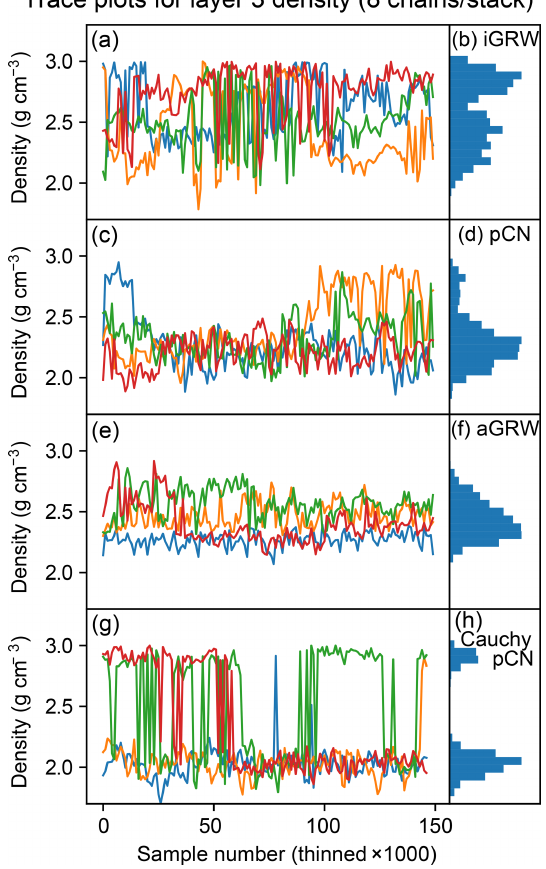
Figure 3. Trace plots (a, c, e, g) and marginal densities (b, d, f, h) for layer 3 rock density as explored by iGRW, pCN, and aGRW proposals, as well as by a pCN proposal under a Cauchy likelihood (top to bottom). The four colors represent the four different